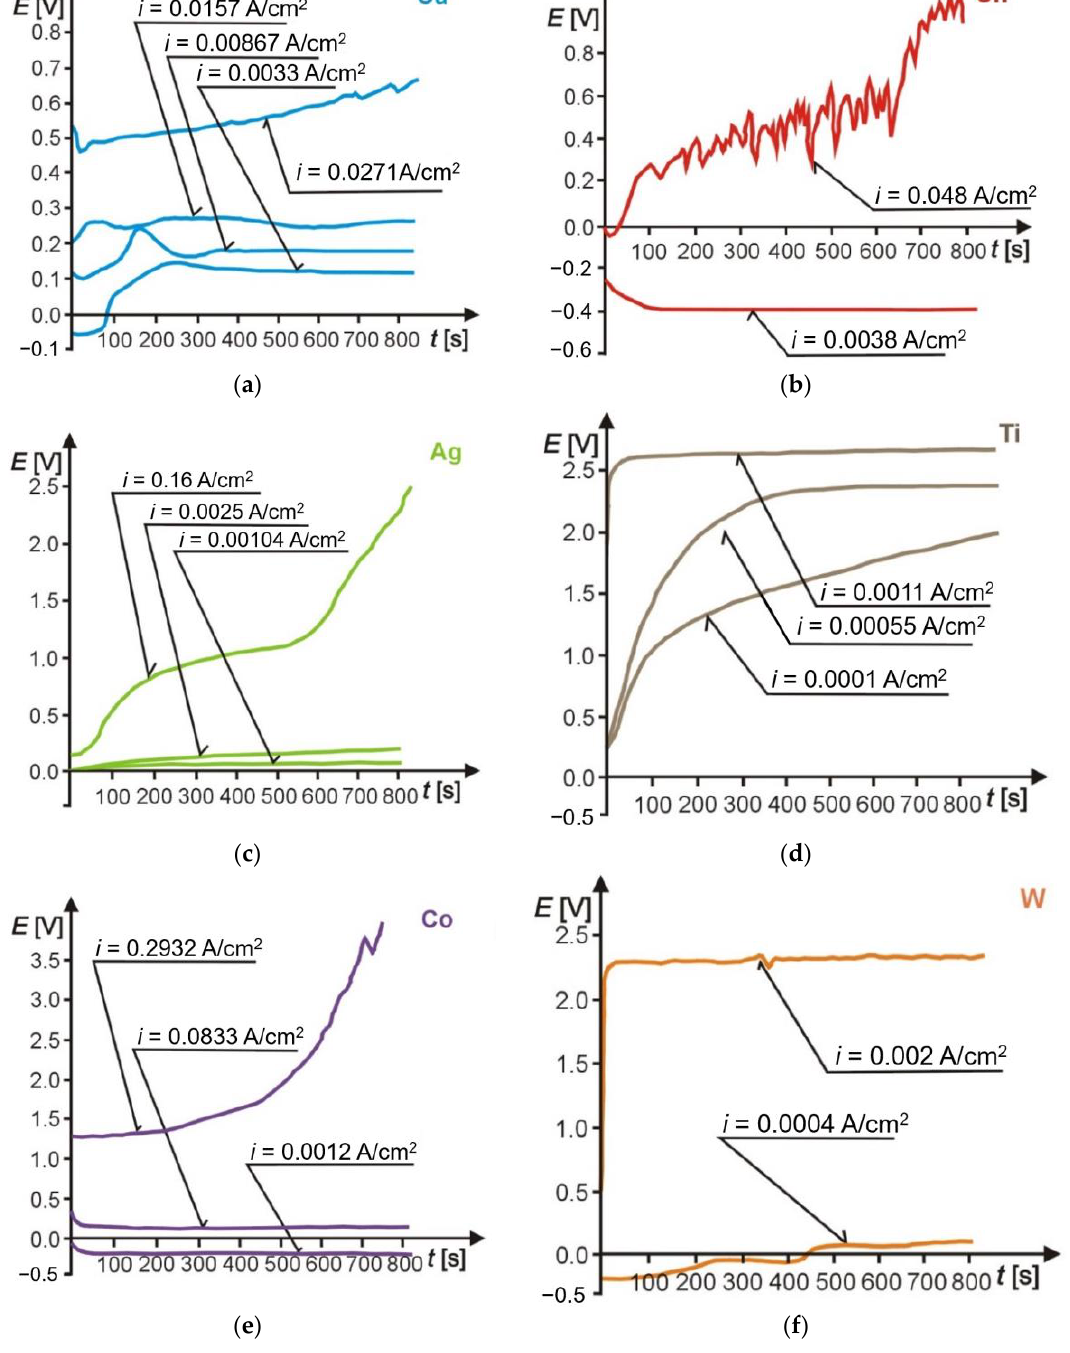
Figure 7. The chrono-volt-amperometric plots of the grinding wheel components: ( a ) Copper; ( b ) Tin; ( c ) Silver; ( d ) Titanium; ( e ) Cobalt; ( f ) Tungsten.